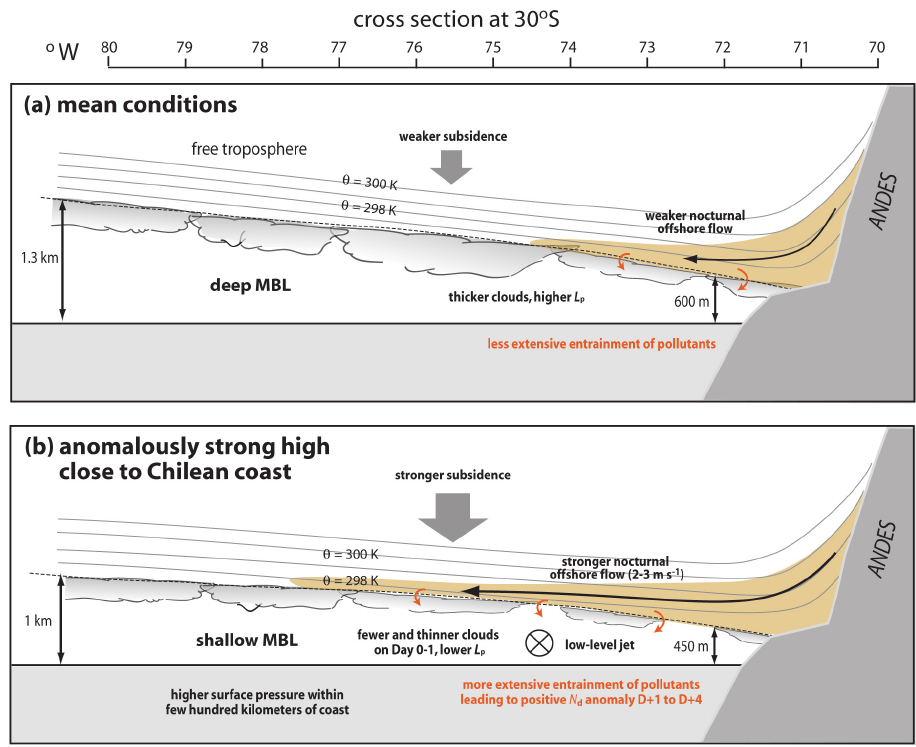
Fig. 12. Conceptual model of hypothesized meteorological mechanism by which cloud variables in the SEP may be influenced by a strong subtropical high near the coast. The top panel demonstrates mean conditions at 30 ◦ S and the bottom represents what is seen in composite differences on maxima in SLP PC2. Brown shading indicates an airmass containing pollutant aerosols.